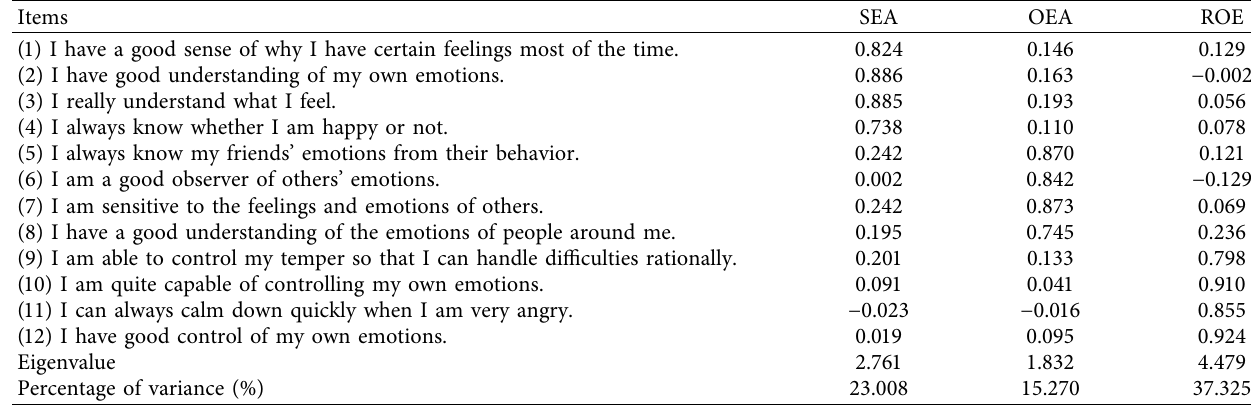
Figure 1: Farmer’s facial expression in print advertising, (a) neutral facial expression, (b) positive facial expression, and (c) product without portrait. Table 1: Measurements of EI and factor analysis results.